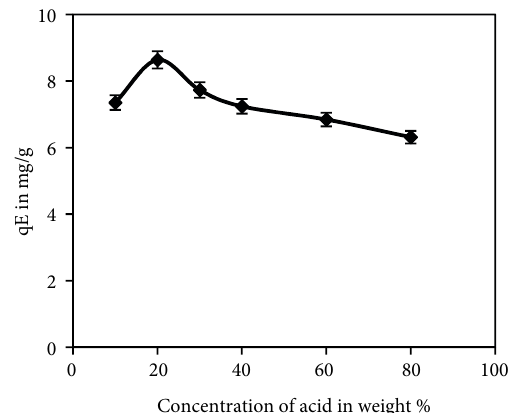
Fig. 1. Effect of acid concentration in weight % at 30 °C, impregnation ration 1:12 and speed of stirring 150 rpm